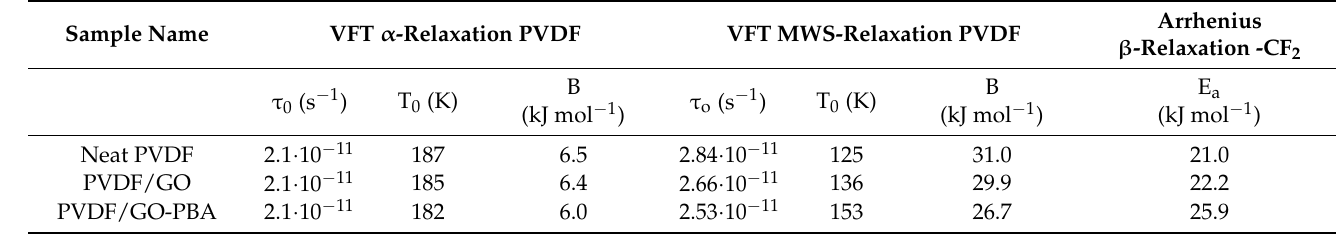
Figure 11. Dielectric 3D plots of neat PVDF (black squares) ( a ) and composites containing PVDF/GO (red down triangles) ( b ) and PVDF/GO-PBA particles (green stars ( c ). Dielectric map of the relaxations present in the PVDF-based systems ( d ). Solid lines in the dielectric map are the best fit of the Arrhenius and VFT model. Table 3. Summarized parameters of the Arrhenius and VFT model fit for fabricated samples.